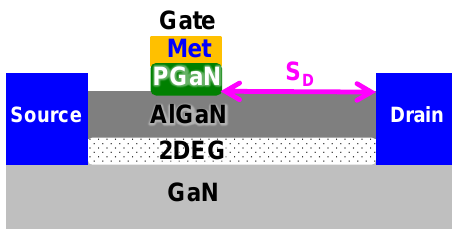
Figure 1. Cross-section of a 650 V GaN E – Mode HEMTs.